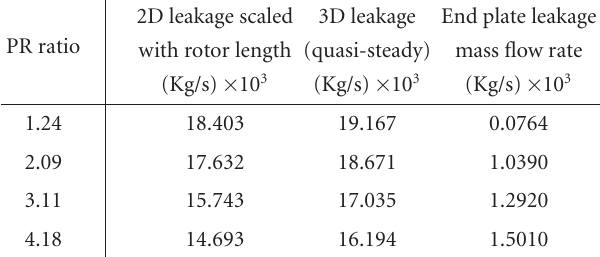
Table 1: Comparison of 3D and 2D leakage mass flow rate results scaled with rotor length (RR = 0 . 014 (cid:8)(cid:8) , RC = 0 . 011 (cid:8)(cid:8) ). 2D leakage scaled 3D leakage End plate PR ratio